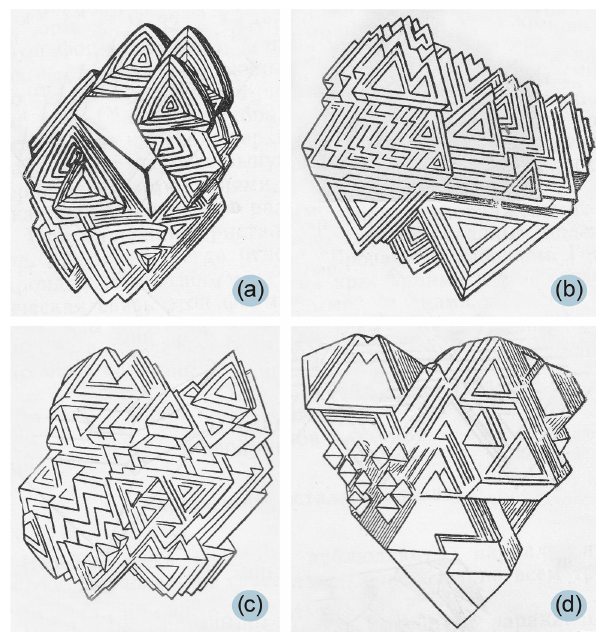
Figure 7. Parallel-growth aggregates of natural diamond crystals, original drawing from the book Morphology of diamond by Yu. L. Orlov (Orlov,